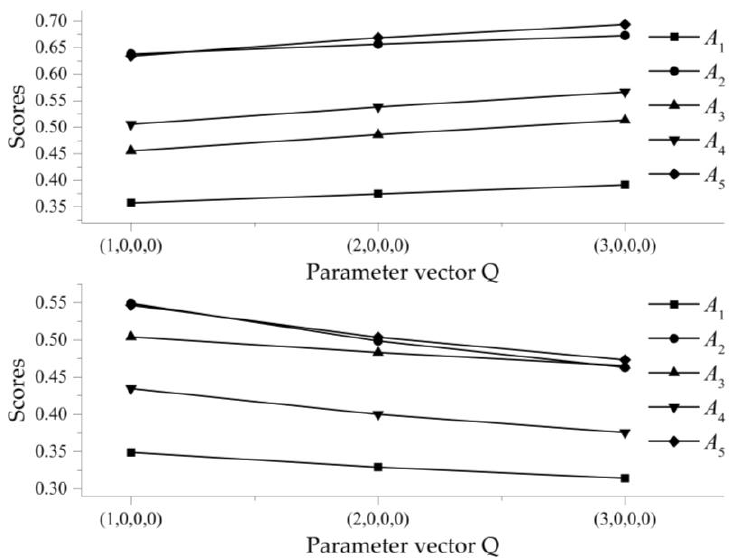
Figure 1. Scores of alternatives for different parameter vector Q .